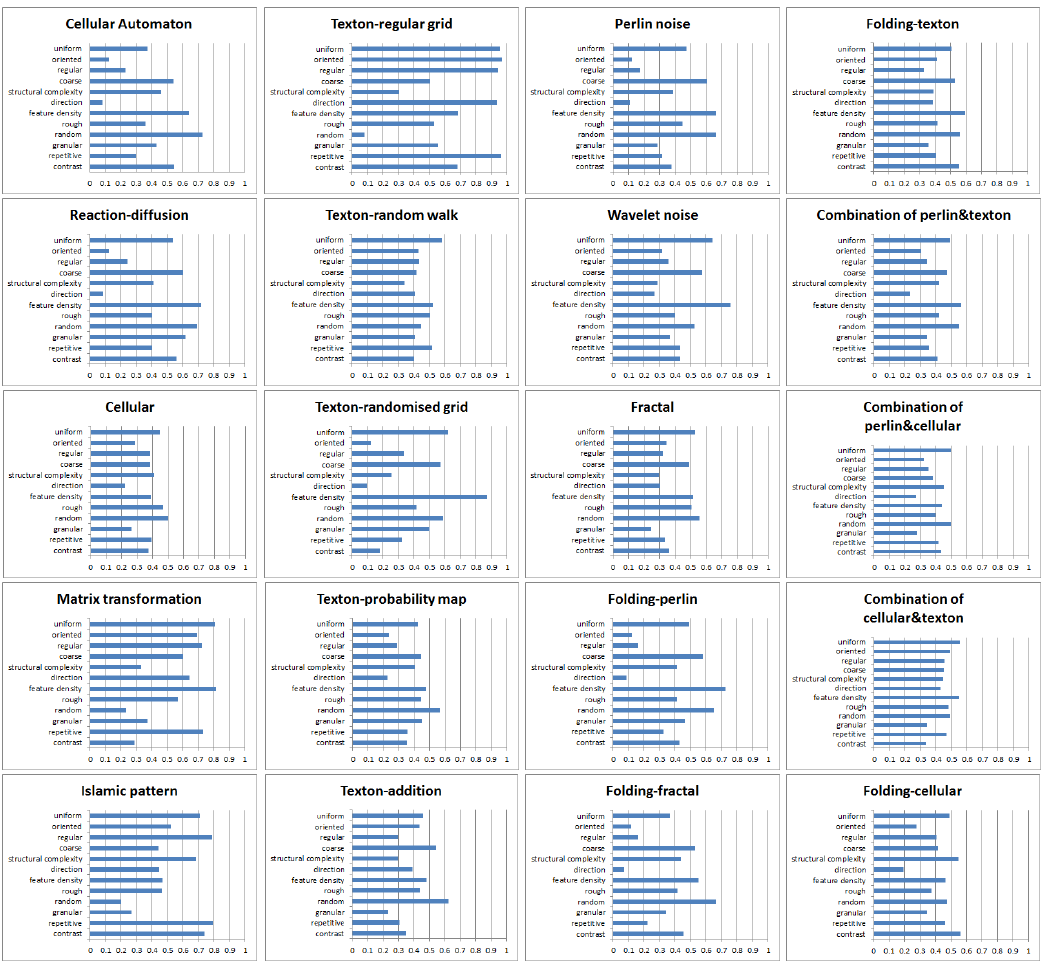
Figure 16. Feature histograms of different texture generation